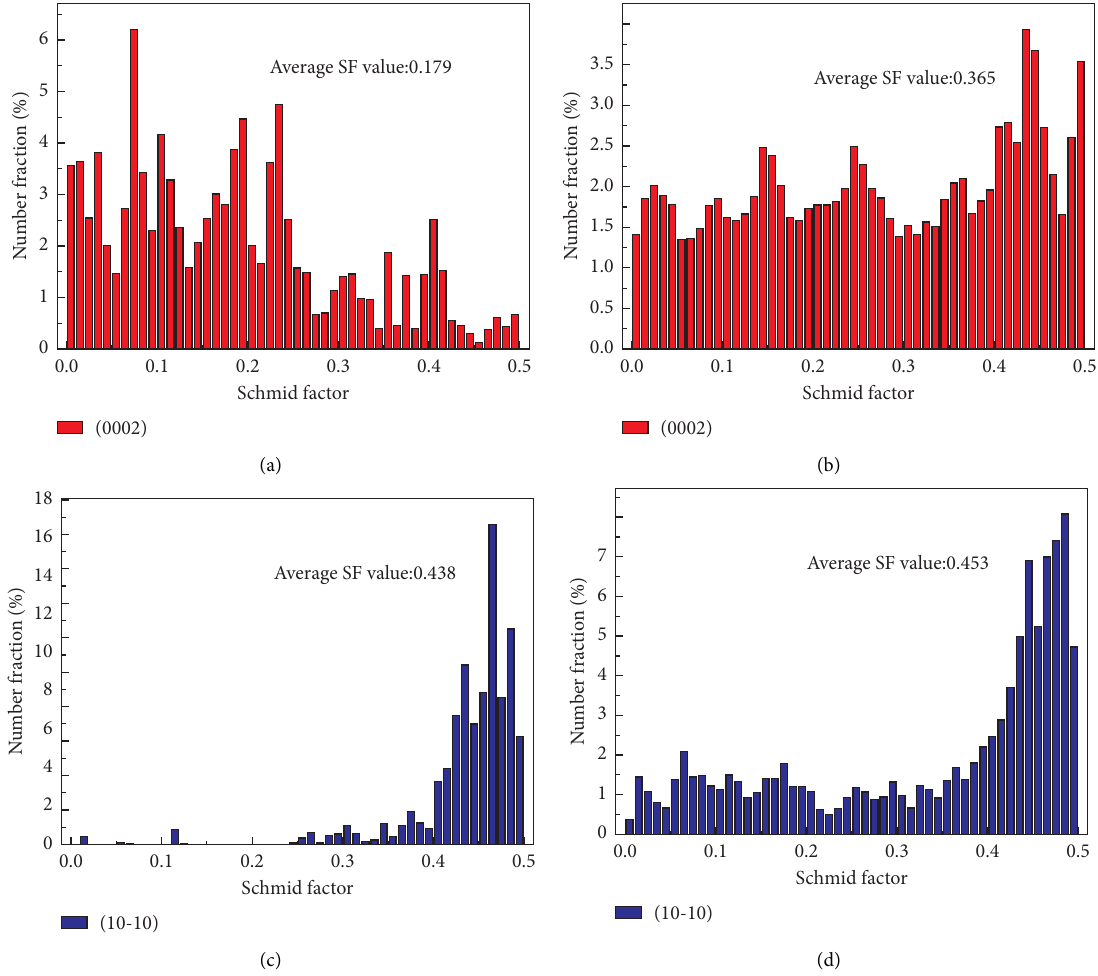
Figure 8: Schmidt factor (SF) distributions of the as-extruded alloys: (a, c) AZ31 and (b, d)